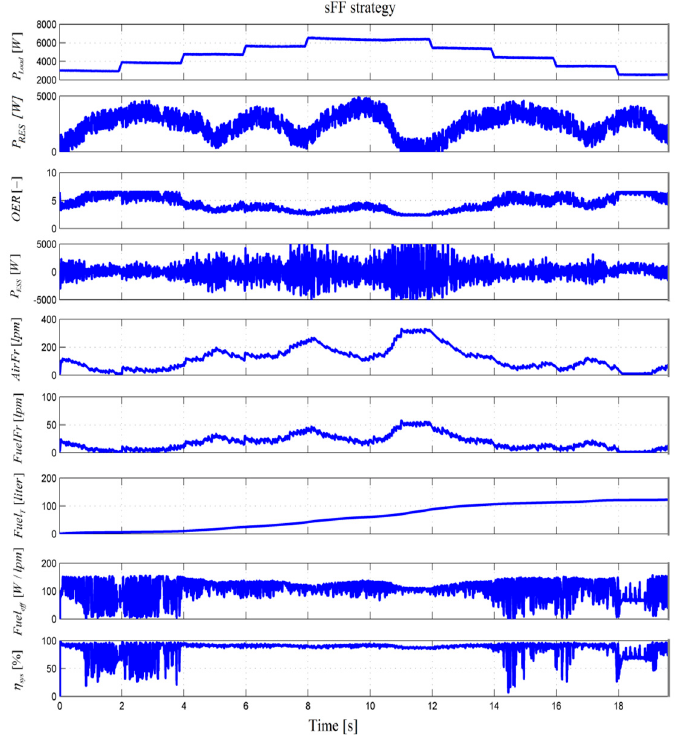
Figure 10. FC / renewable HPS behavior using sFF Figure 10. FC/renewable HPS behavior using sFF strategy.